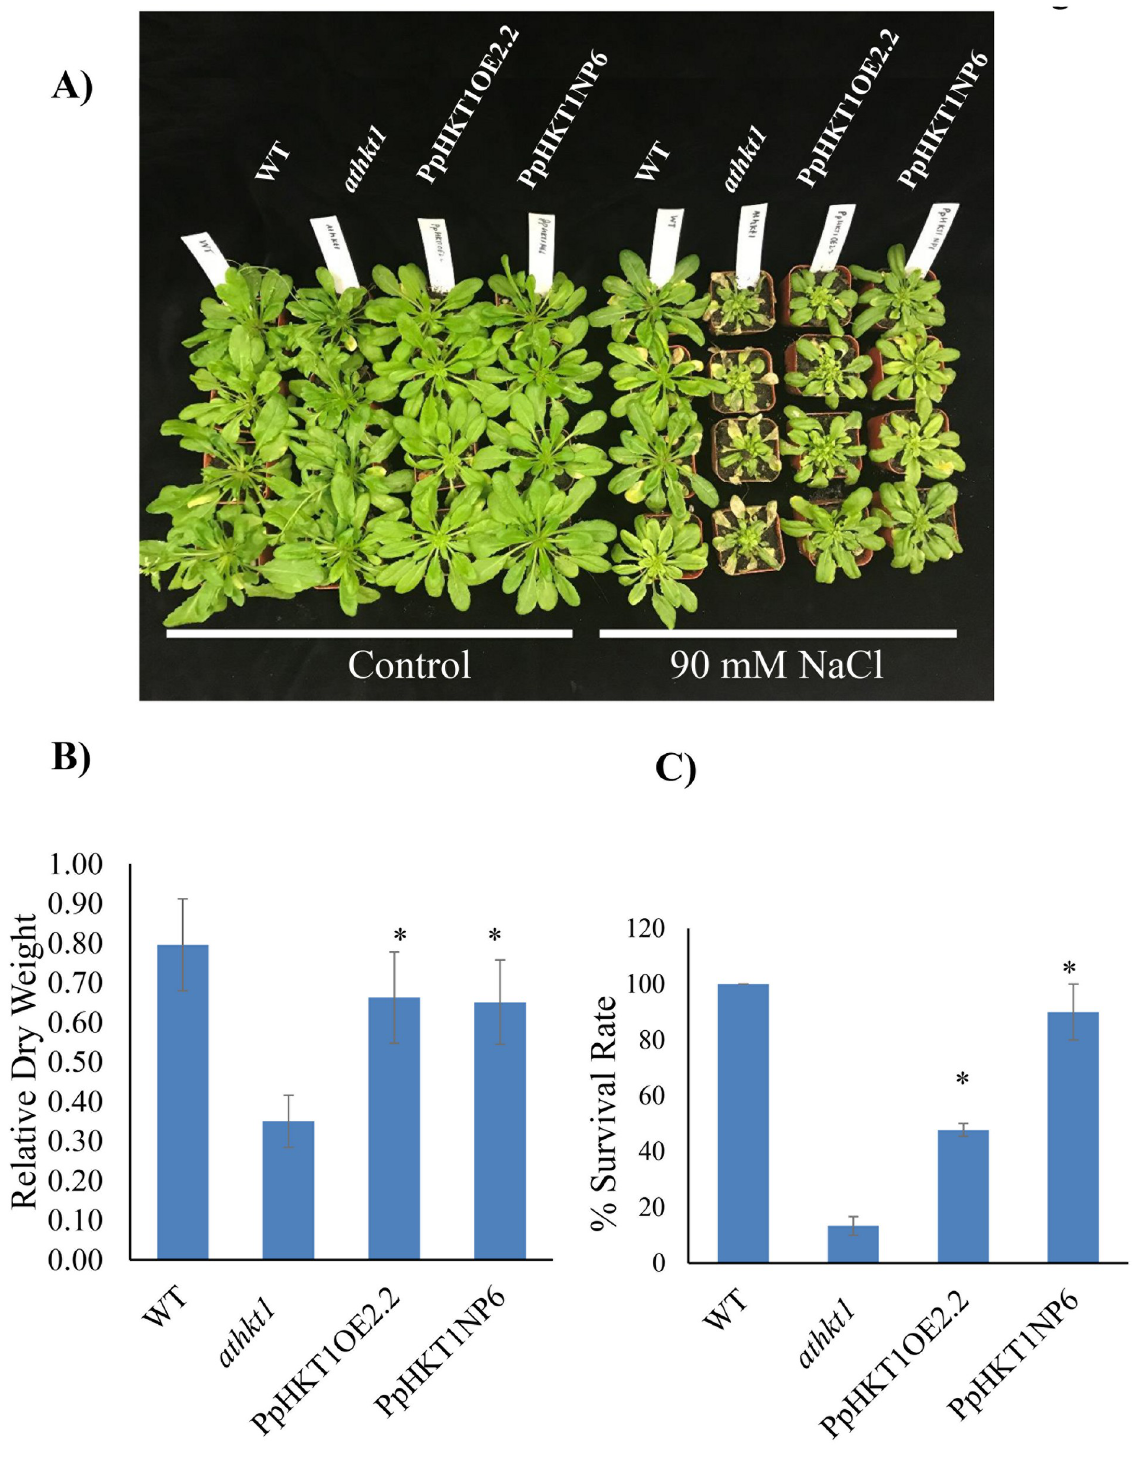
Fig 2. Salt tolerance assays. A ) WT plants, the athkt1 mutant and the transgenic lines PpHKT1OE2.2 and PpHKT1NP6 were treated with 90 mM in 1/8-strength-MS media for 18 days. B ) Plant relative dry weight (DW) of the athkt1 mutant plants under salinity significantly decreased compared to PpHKT1OE2.2 and PpHKT1NP6 plants. C ) The transgenic plants showed higher % survival compared to the Arabidopsis mutant athkt1 after three weeks of salt treatment of 90 mM NaCl. ANOVA single factor was used to depict the statistical differences between the athkt1 mutant and each of the transgenic lines. P � 0.05 ( � ).